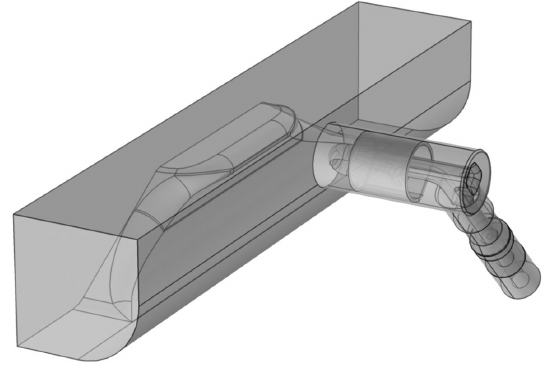
FIG. 8. A quarter of the WOWCC with an HOM coupler similar to those used for the DQWCC [33]. The coupler is located at the cavity center vertically displaced by 40 mm and rotated by 45 deg.